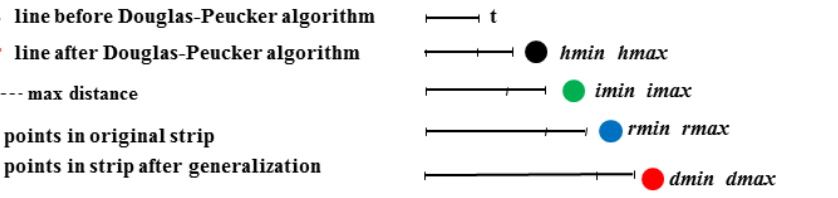
Figure 2. Introduced modification for Douglas-Peucker algorithm